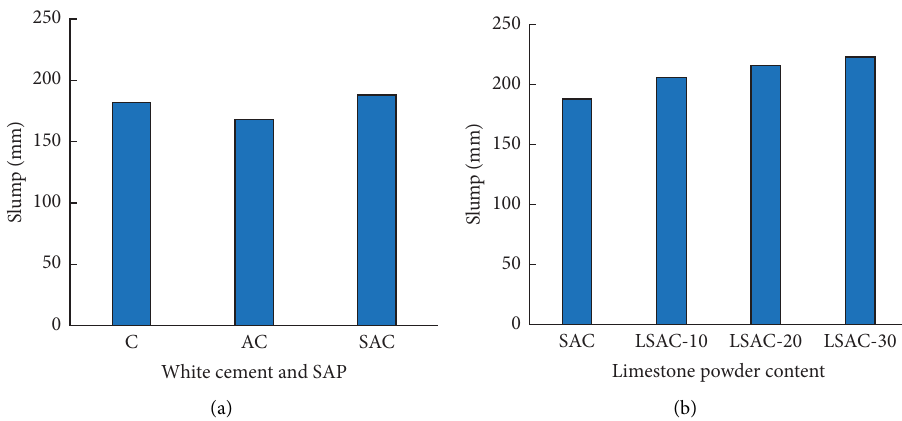
Figure 2: Slump of diferent types of fair-faced concrete. (a) Efects of white cement and superabsorbent resin. (b) Efect of limestone powder